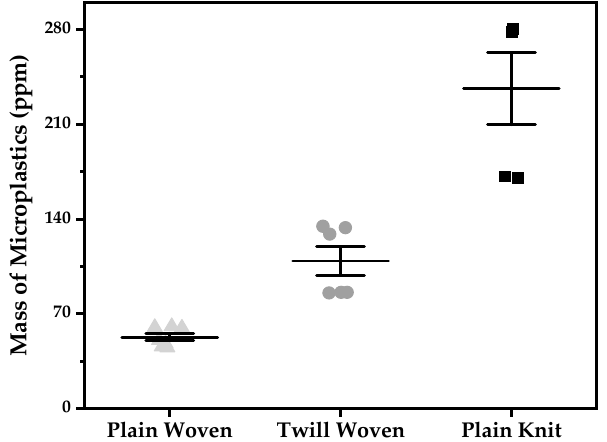
Figure 3. Mass of microplastics released from washing.